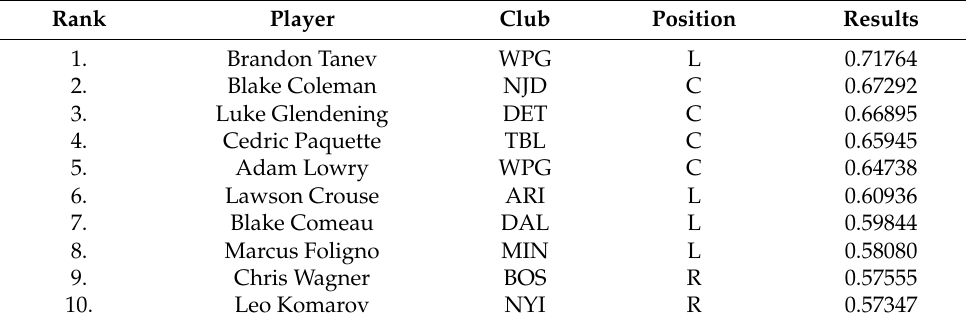
Table 7. Ten best players as evaluated by the SD–TOPSIS combination.